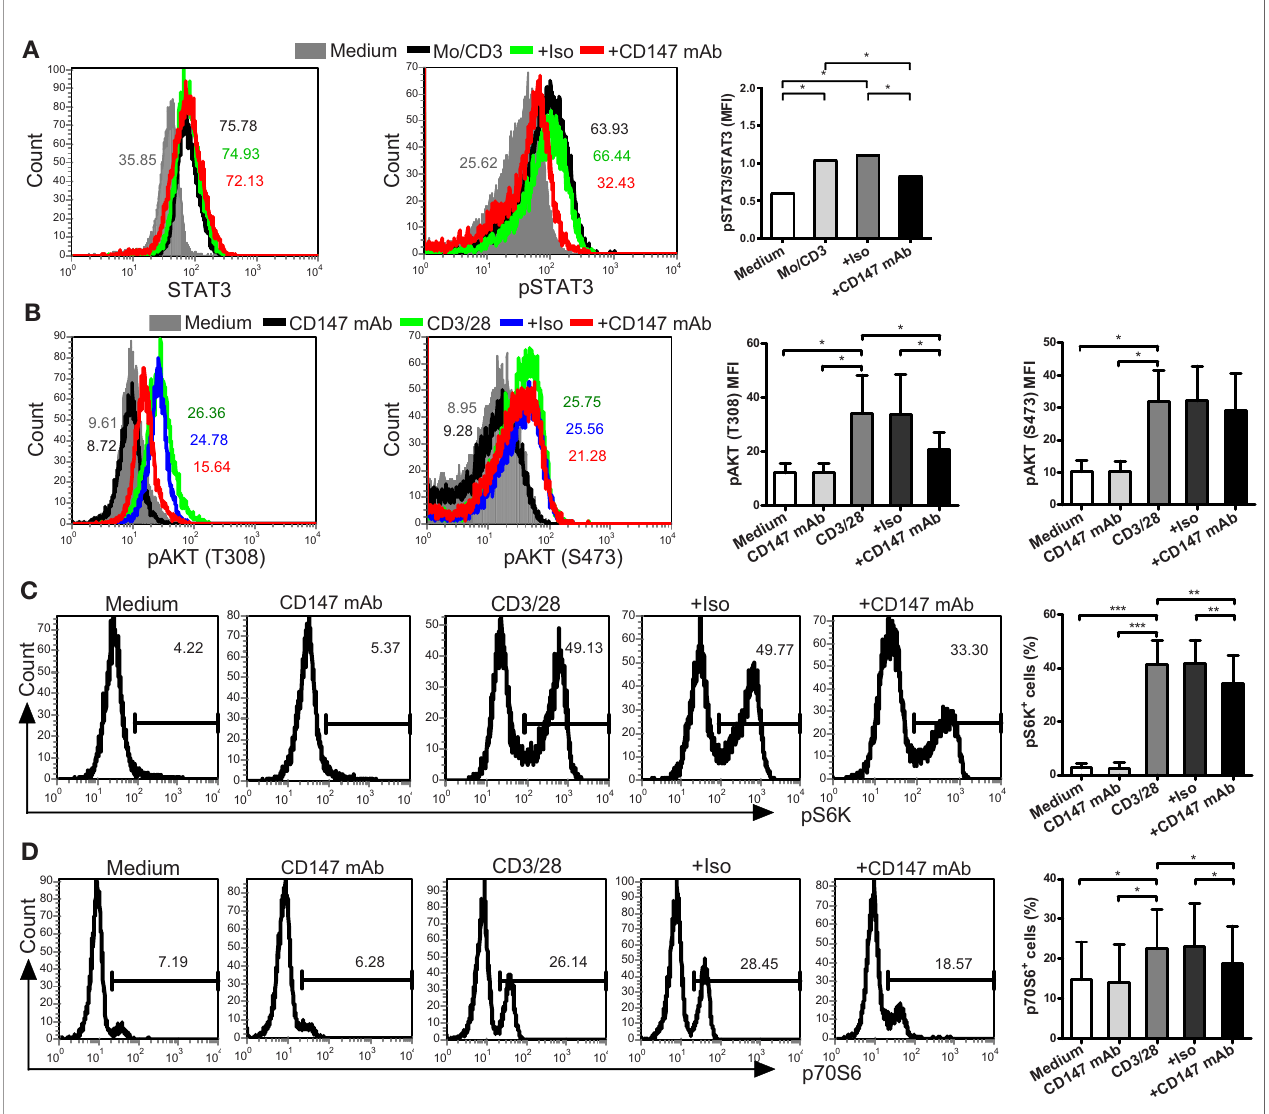
FIGURE 3 | Anti-CD147 mAb inhibits AKT, mTOR and STAT3 signaling. (A) CD4 + Tm cells from HC were cocultured with medium or LPS-activated Mo and anti-CD3 mAb in presence of isotype control mAb (Iso) or anti-CD147 mAb for 3 days, then the expression of STAT3 and pSTAT3 were assessed by fl ow cytometry (n = 7). (B) Phospho- fl ow analysis of pAKT (T308) and pAKT (S473) in CD4 + Tm cells from HC with medium or anti-CD147 mAb, with or without Iso or anti-CD147 mAb stimulated with anti-CD3 and anti-CD28 mAb for 5 min (n = 7). (C, D) Phospho- fl ow analysis of pS6K (n = 7; (C) and p70S6 (n = 6; (D) in CD4 + Tm cells from HC with medium or anti-CD147 mAb, with or without Iso or anti-CD147 mAb stimulated with anti-CD3 and anti-CD28 mAb for 30 min. * P < 0.05; ** P < 0.01; *** P <